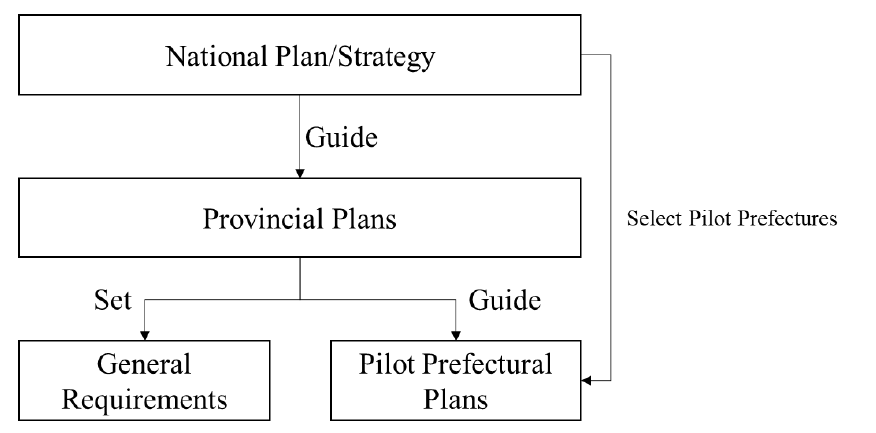
Figure 3. China ’ s climate strategies and plans system. Figure 3. China’s climate strategies and plans